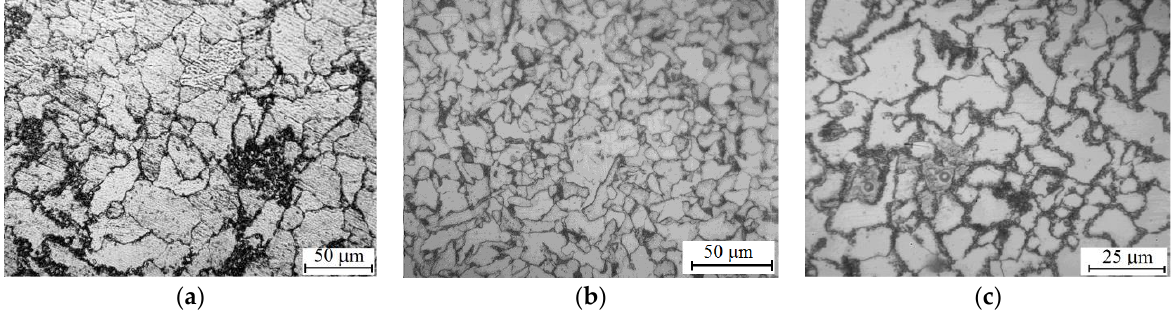
Figure 1. Optical images of the coating structure formed using: ( a ) the commercial electrode; experimental electrodes with the titanium carbonitride content 0.25 wt% ( b ) and 1 wt% ( c ).